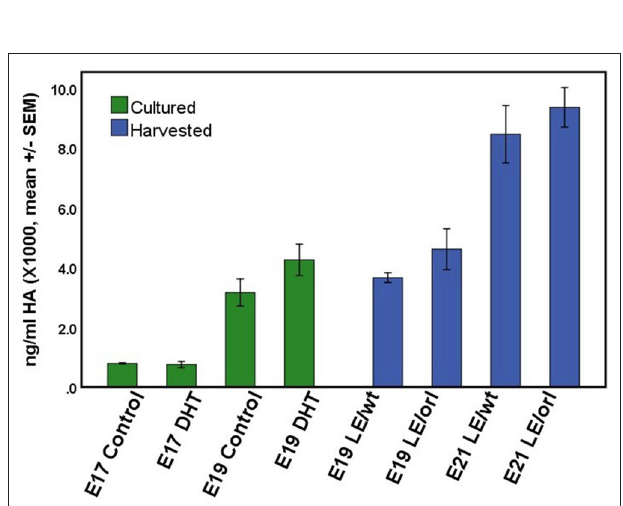
FIGURE 6 | HA concentration did not differ significantly between LE/wt E17 or E19 gubernacula cultured with and without exposure to 10nM DHT (green bars; n = 5–6 per treatment group per time point) or between LE/wt and LE/orl gubernacula harvested at E19 or E21 (blue bars; n = 4 per strain per time